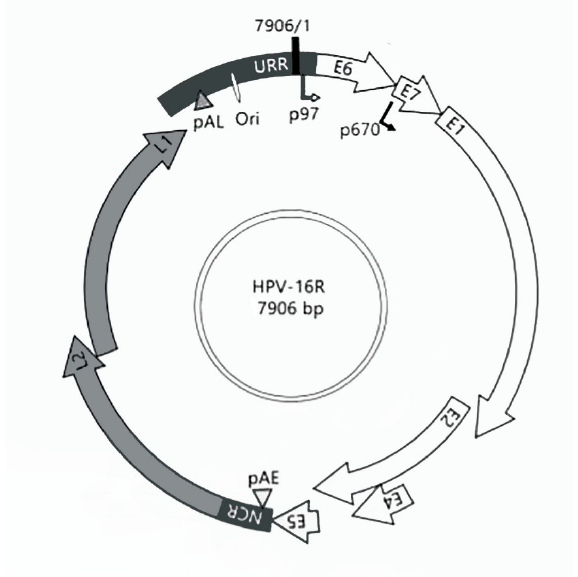
Figure 1. Schematic of the HPV-16R genome. The genome organization of 7906 base pairs (bp) arranged in a circular form represents the three functional regions, early, late, and long control (LCR); and a non-coding region (NCR). These are separated by two polyadenylation sites, described as early (pAE) and late (pAL). In total, the genome encodes eight open reading frames (ORFs), of which E1, E2, E4, E5, E6, and E7 are from the early region; and L1 and L2 are from the late region. The LCR, located between the E6 and L1 gene, is a regulatory region that includes the origin of replication (ori) and the p97